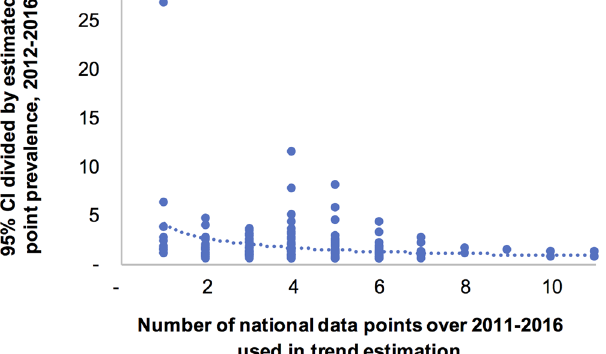
Figure 4. Relation between number of national prevalence data points, and precision of point prevalence estimates. Notes to Fig. 4: Precision expressed, on the y-axis, as the width of the 95% CI (averaged between 2012 & 2016) divided by the point estimate. Each dot represents a country with a Spectrum national trend estimate based on data from ANC and general